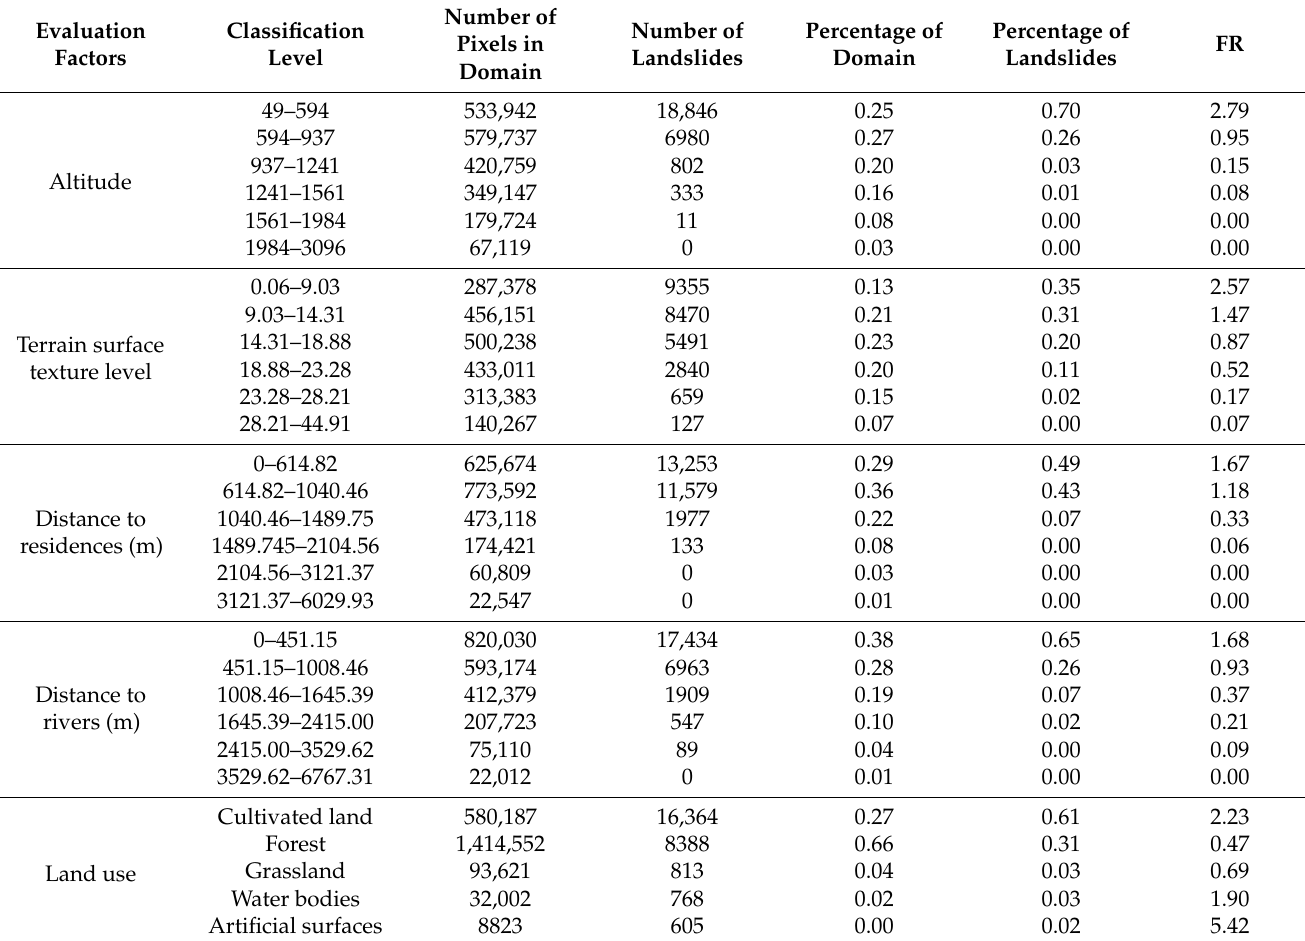
Table 2. Statistical zoning table for the top five impact